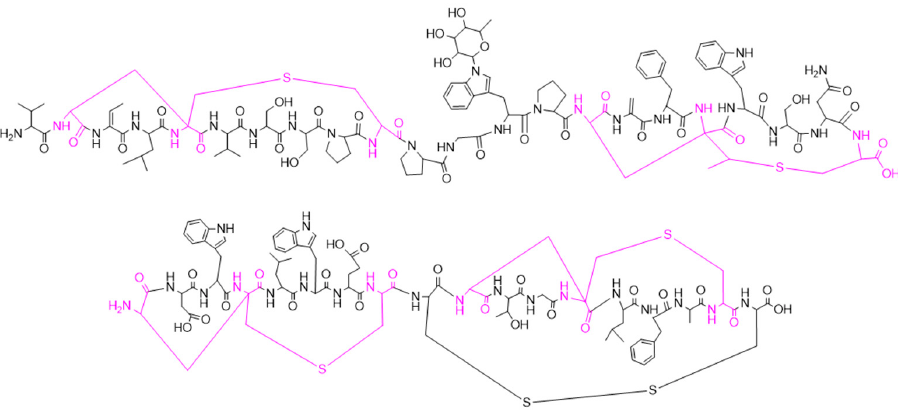
Figure 1. Structures of NAI ‐ 112 ( upper ) and labyrinthopeptin A2 ( lower ). In pink, the amino acids involved in the labionin bridges are highlighted.